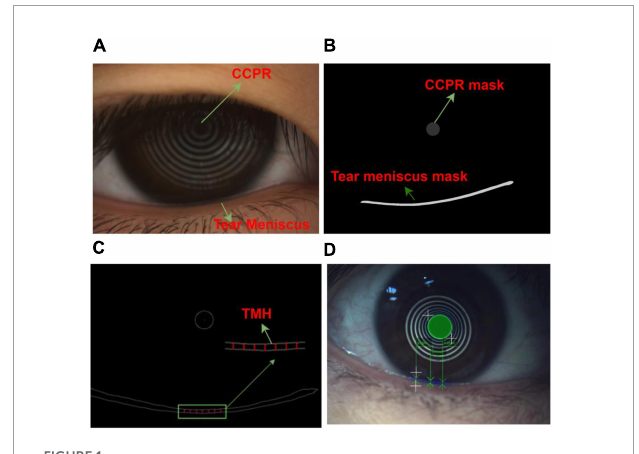
FIGURE1 Ocular surface image data (A) Original ocular surface image (B) Segmentation convolution neural network segmented tear meniscus region and central ring of corneal projection ring (CCPR) region (C) Schematic of selected TMH measurement region (D) Schematic of physician assessment of